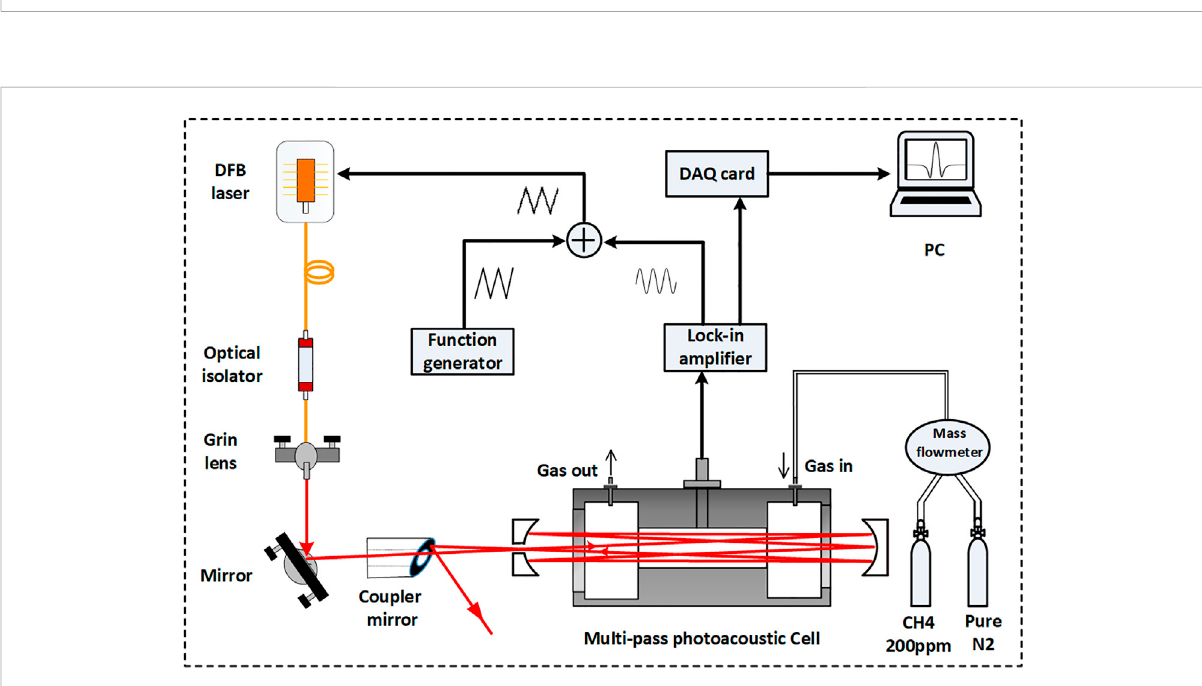
FIGURE 2 Schematic experimental setup of a multi-pass PA sensor for trace gas